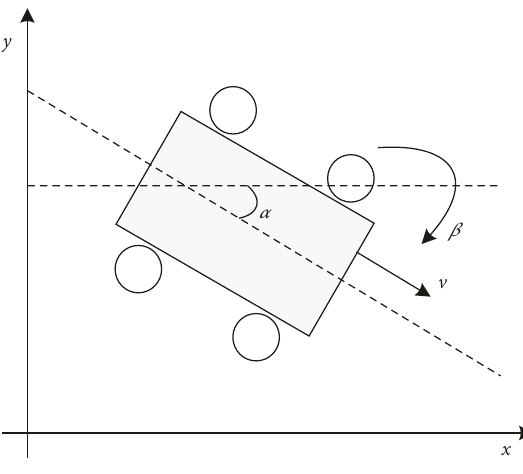
Figure 1: Basic structure of the Pioneer3 mobile